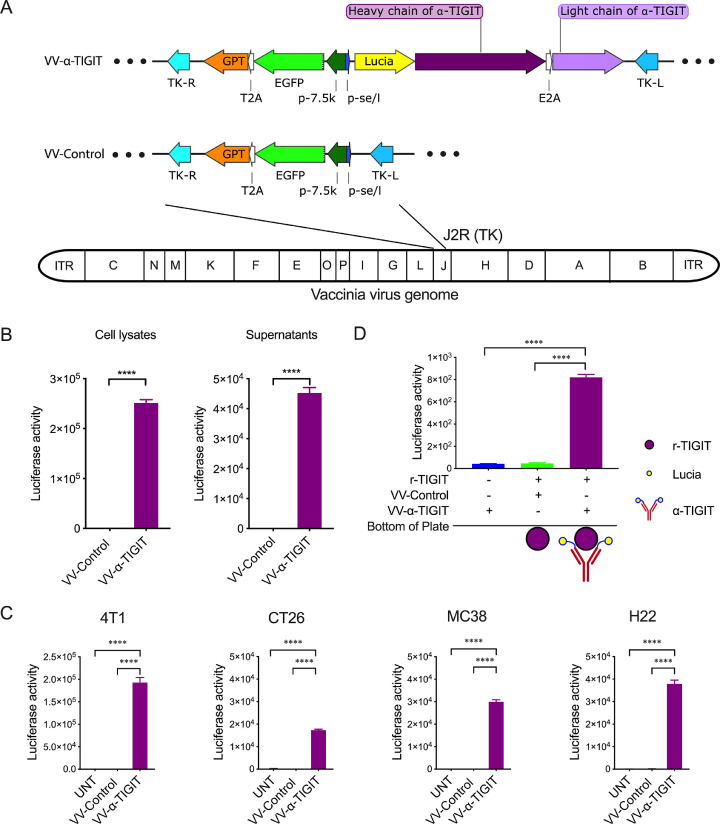
Generation and characterization of recombinant oncolytic VVs. (A) A schematic diagram of the recombinant VVs with (VV-α-TIGIT) or without (VV-Control) α-TIGIT gene. TK-R, right flank sequences of thymidine kinase gene; TK-L, left flank sequences of thymidine kinase gene; GPT, guanine phosphoribosyl transferase; EGFP, enhanced green fluorescent protein; p-7.5k, vaccinia virus p-7.5k early/late promoter; p-se/l, synthesized vaccinia virus early/later promoter; T2A, thoseaasigna virus 2A; E2A, equine rhinitis A virus 2A; (B) Expression and secretion of α-TIGIT in VV-infected Hela-S3 cells. Hela-S3 cells were infected with indicated VVs at MOI of 1 for 24 h, and the levels of α-TIGIT antibody in the cell lysates and supernatants were detected by a luciferase assay. Data are expressed as means ± SD. The experiment was repeated three times. Statistical differences were estimated using the student's t-test. ⁎⁎⁎⁎P < 0.0001. (C) Secretion of α-TIGIT in VV-infected 4T1, CT26, MC38, and H22 cells. The detection of α-TIGIT is similar to that described in (B). Statistical differences were estimated using the ANOVA. ⁎⁎⁎⁎P < 0.0001. (D) Luciferase-linked immunosorbent assay was used to investigate the binding of the secreted α-TIGIT antibody to the recombinant TIGIT (r-TIGIT) protein. The 96-well plate was coated with r-TIGIT (10 μg/ml), and the supernatants of cells infected with VVs were added to the plate. After three rounds of washing, a luciferase assay was used to verify the binding of the secreted α-TIGIT antibody to the r-TIGIT protein. Data are expressed as means ± SD. The experiment was repeated three times. Statistical differences were estimated using analysis of variance (ANOVA). ⁎⁎⁎⁎P < 0.0001.